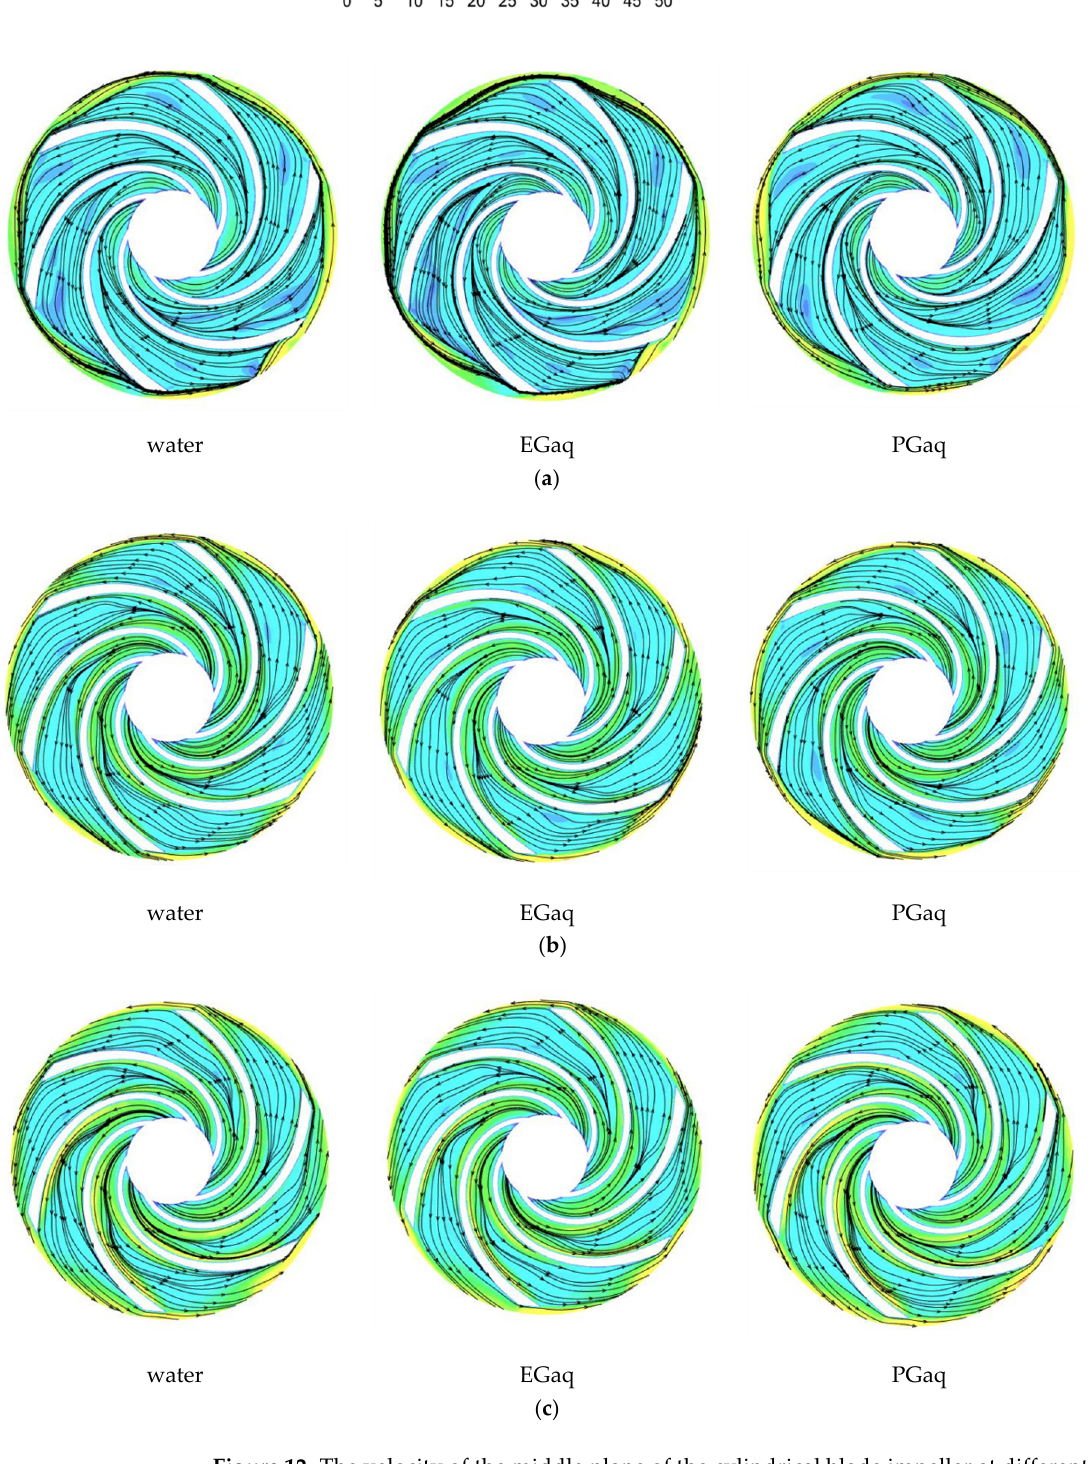
Figure 12. The velocity of the middle plane of the cylindrical blade impeller at different flow